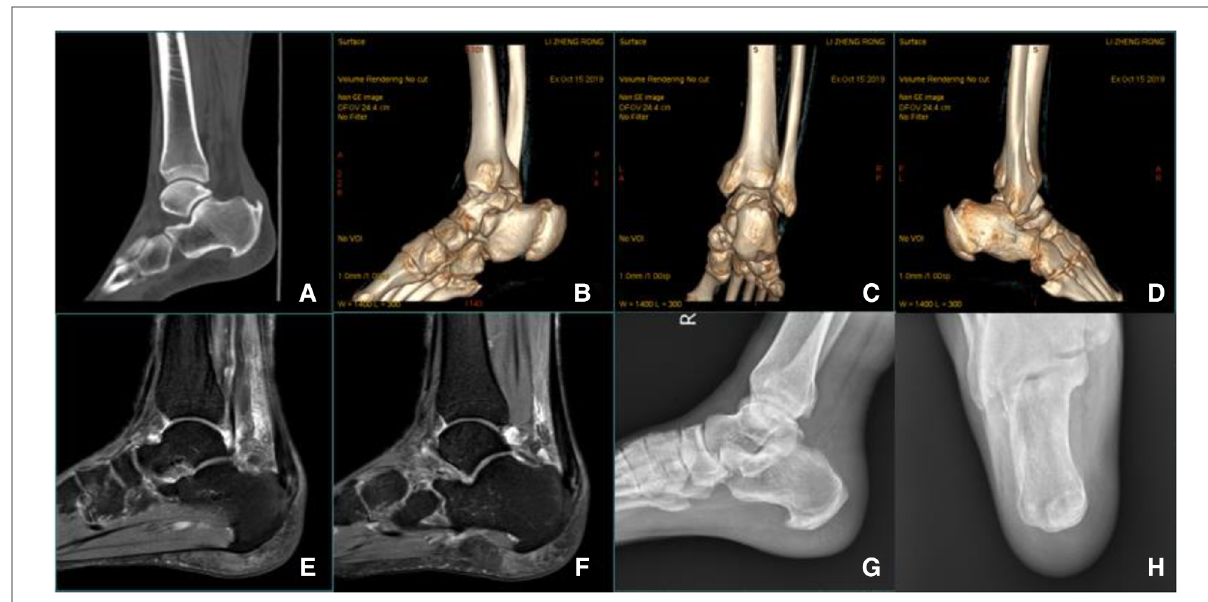
FIGURE 5 ( A – D ) Preoperative CT scan: Calci fi cation of Achilles tendon insertion was evident, accompanied by Haglund deformity. ( E, F ) Preoperative MR imaging: Denaturation and calci fi cation at the insertion of the Achilles tendon, fl uid accumulation behind the ankle joint, and compression of the fl exor hallucis longus tendon. ( G, H ) Postoperative radiography: The posterior calcaneus was fl at, and there was no Haglund deformity at the insertion of the Achilles